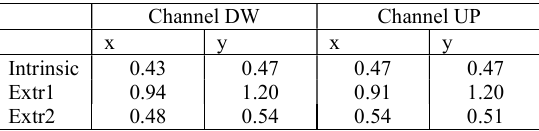
Table 5 Mean value of the standard deviation of the residuals in the three pipeline phases. Considering the results provided in the previous section only physical results are here reported.